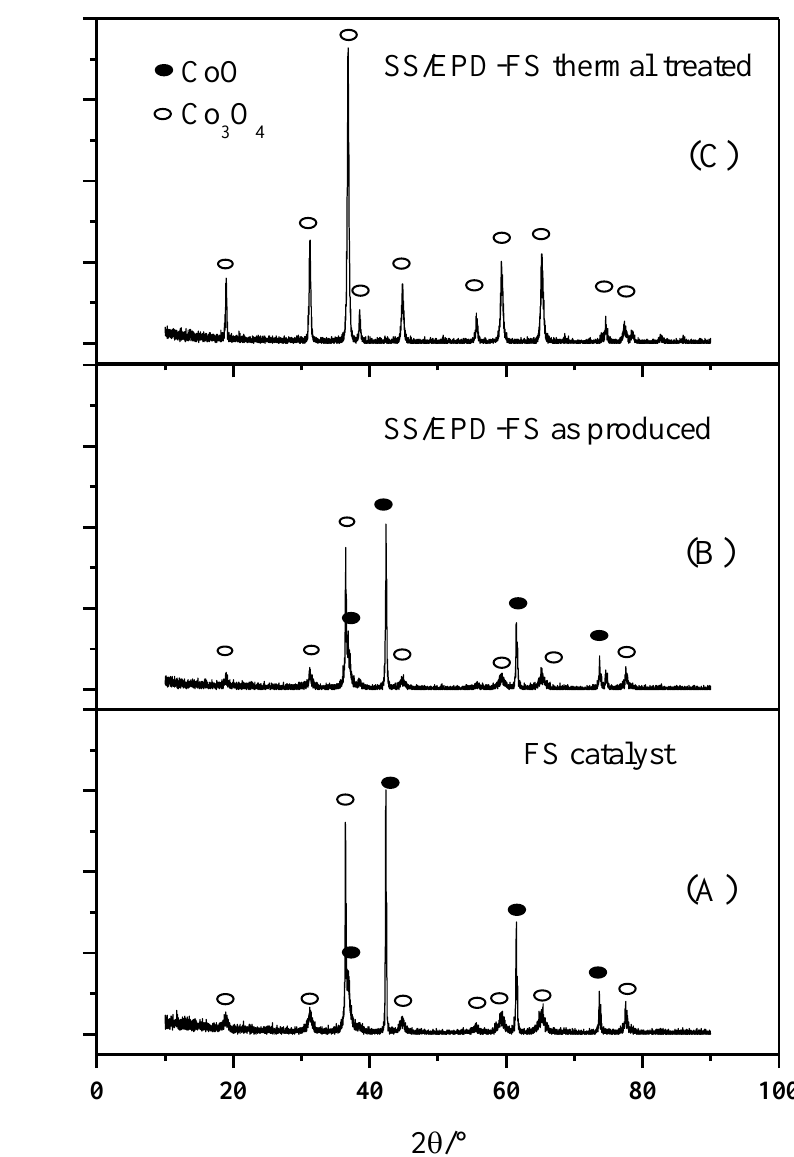
Figure 3. XRD of flame spray catalyst ( A ), after EPD ( B ), and after EPD and thermal treatment at 600°C in air for 5 h ( C ).